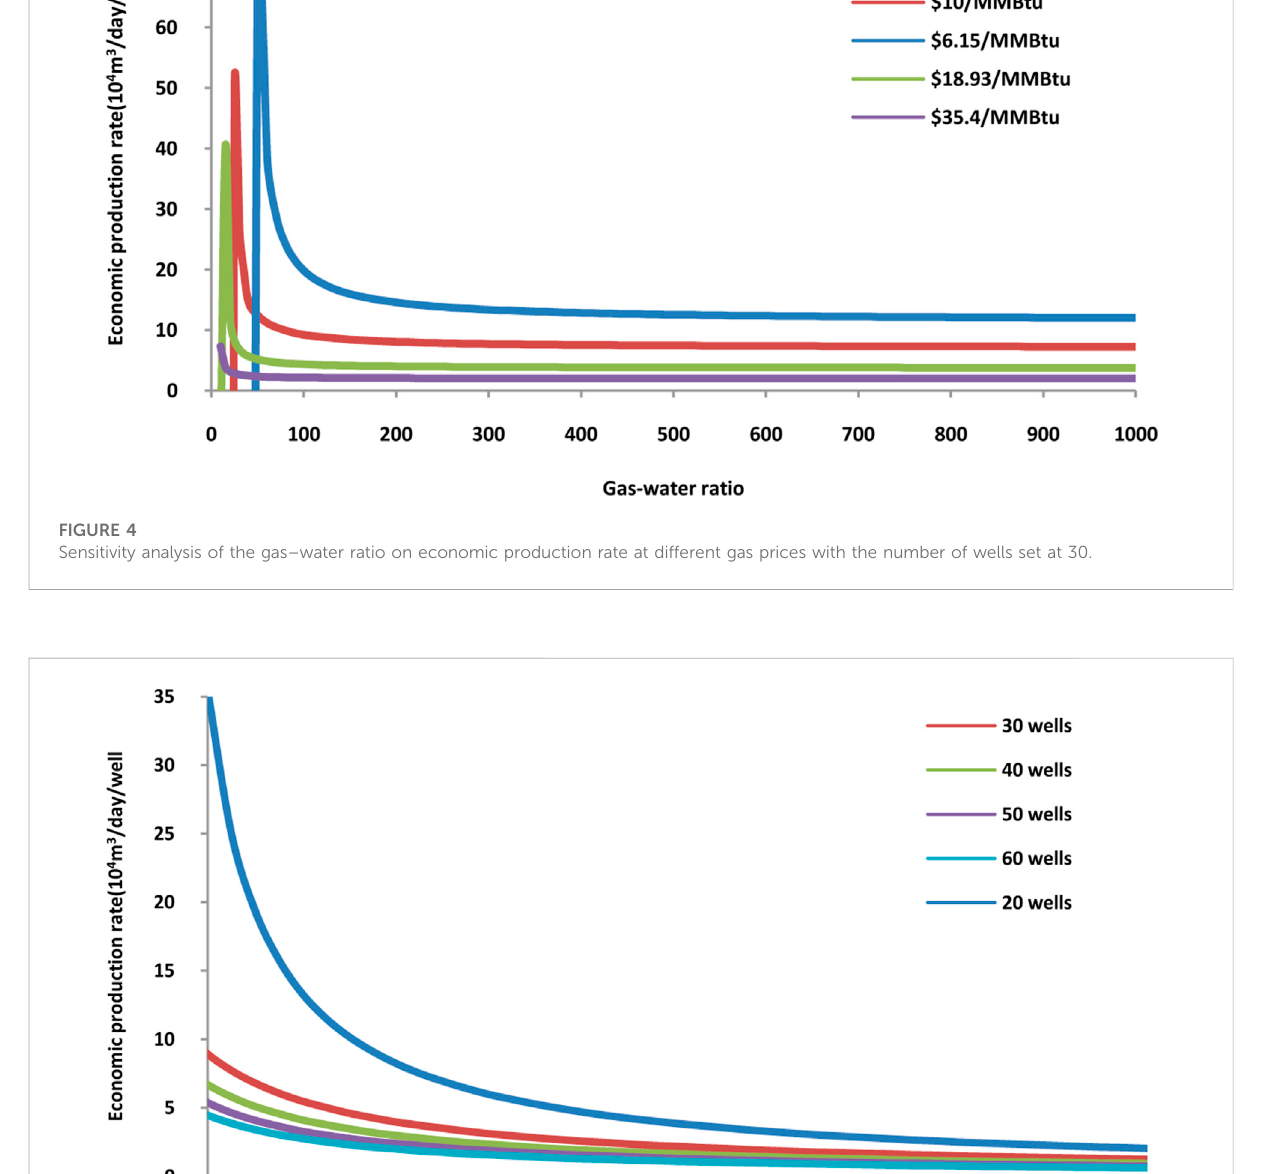
Figure 6 describes the impact of different rates of decreasing production costs on the economic production rate. Gas price